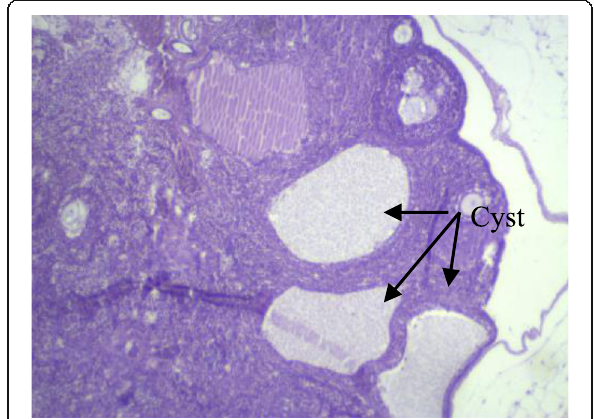
Fig. 3 Cross-section of rat ovary in the PCOS group (× 100, H&E). Cystic follicles are clearly visible in the section of